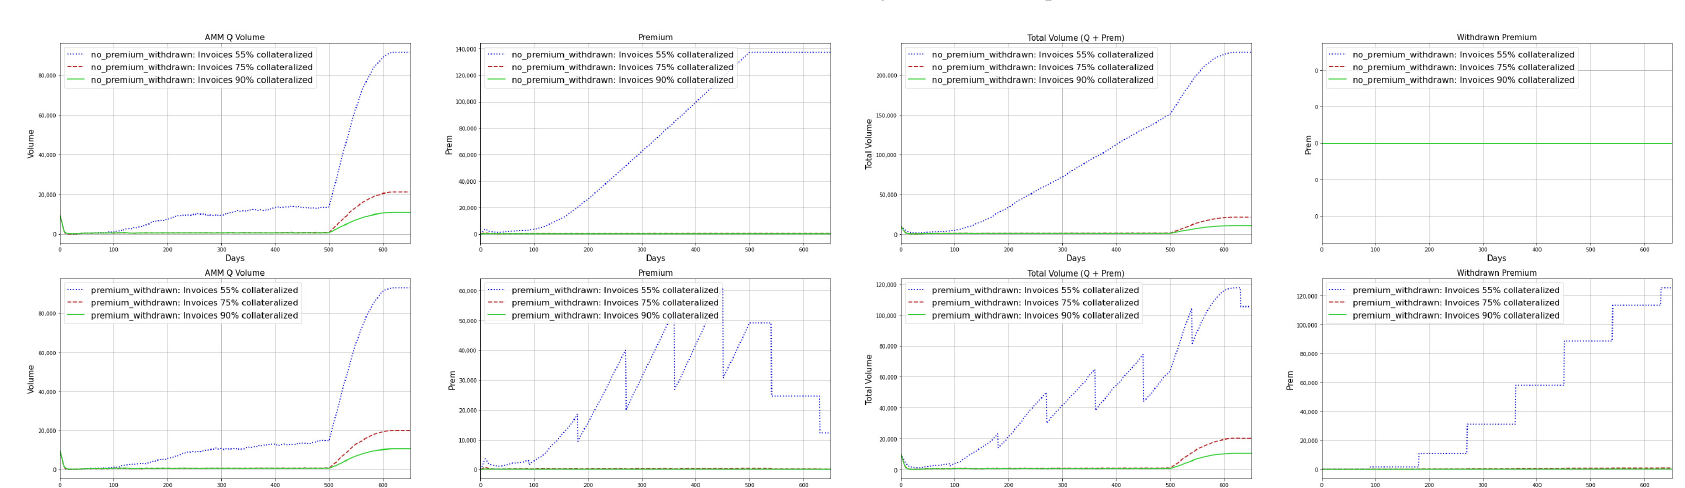
Figure A13. rkAMM Curves from simulation of scenario 5 and 1 day of withdrawal period.